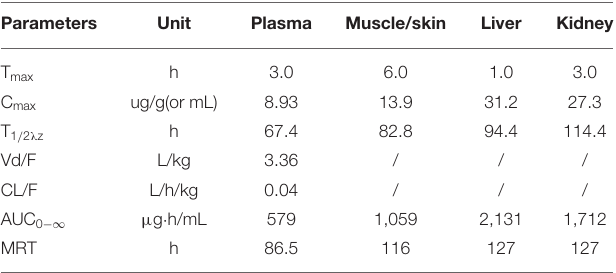
TABLE 1 | Pharmacokinetic parameters of enrofloxacin in the plasma and tissues of crucian carp after oral administration of a single dose (20 mg/kg b.w.) at 28 ◦ C. Parameters